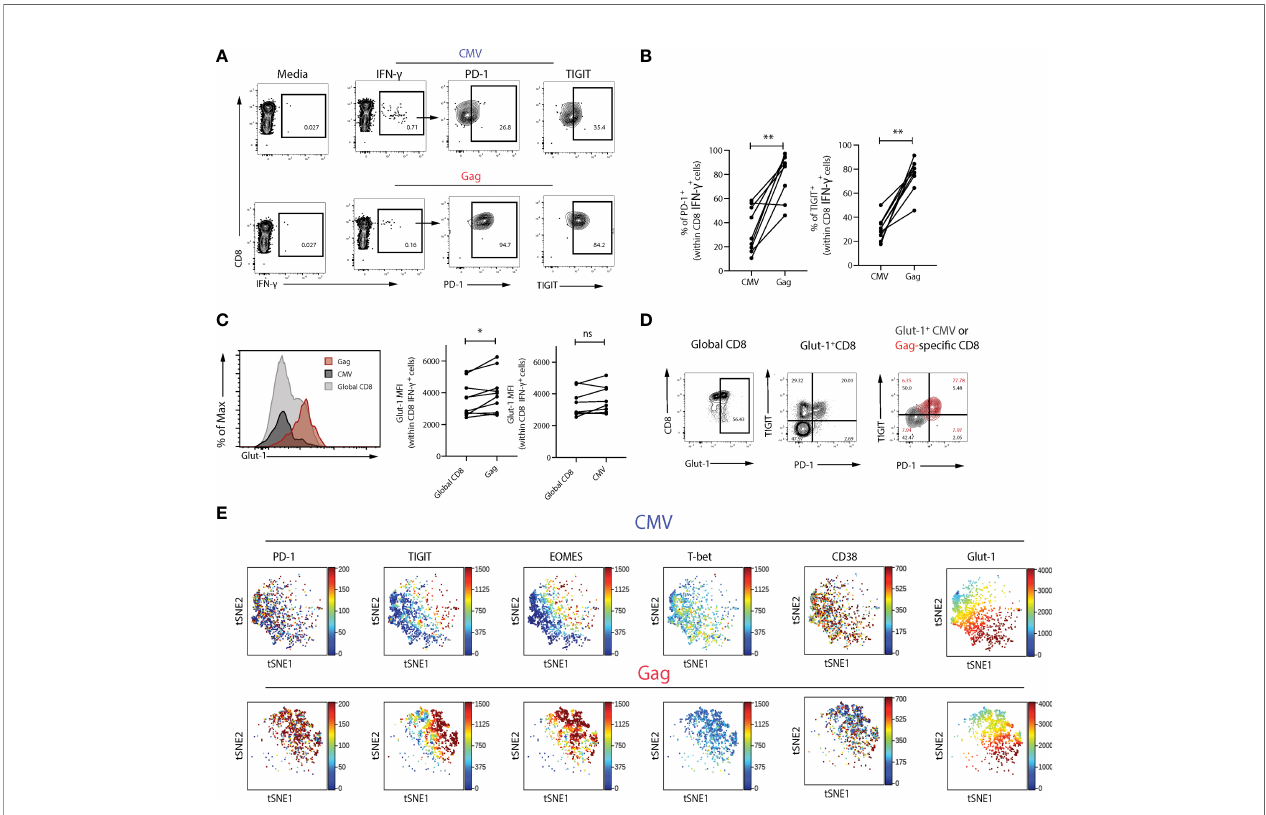
FIGURE 2 | Glut-1 expression is enriched within exhausted Gag-speci fi c compared to CMV-speci fi c CD8 T cells. (A) Representative fl ow plots of PD-1 and TIGIT expression in Gag- and CMV-speci fi c CD8 T cells following 6-hour stimulation with HIV-1 (Gag) or CMV (pp65) peptides directly ex-vivo . (B) Summary data of frequency of PD-1 + or TIGIT + cells within Gag or CMV virus-speci fi c populations from n = 9 viraemic HIV-1 infected donors in paired samples. (C) A representative histogram overlay of Glut-1 MFI in global, Gag- and CMV-speci fi c CD8 T cells from n = 9 viraemic HIV-1 positive donors and summary data comparing Glut-1 MFI in global and Gag- or CMV-speci fi c CD8 T cells in paired samples. (D) Flow plots of Glut-1 expression in global CD8 T cells and Gag and CMV-speci fi c CD8 T cells (overlaid) co-expressing TIGIT and PD-1. (E) ViSNE analysis of Gag or CMV-speci fi c CD8 T cells from n = 5 viraemic HIV-1 individuals showing expression of PD-1, TIGIT, EOMES, T-bet, CD38, and Glut-1. Wilcoxon matched-pairs signed rank test,*p < 0.05, **p < 0.005. ns, non-signi fi